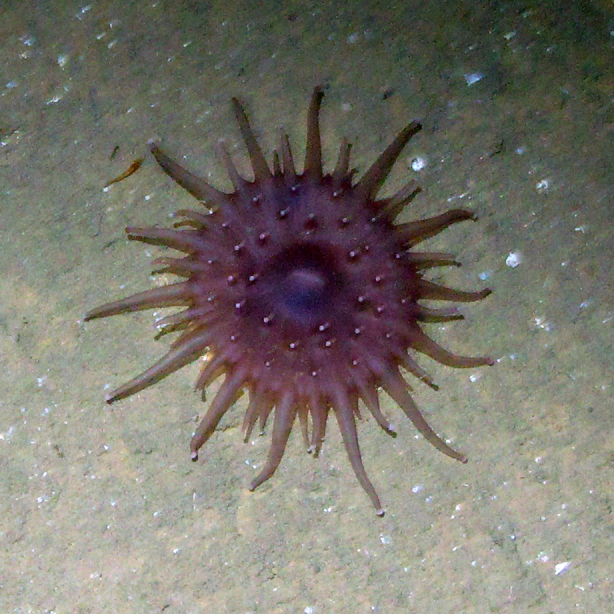
Corallimorphus sp.